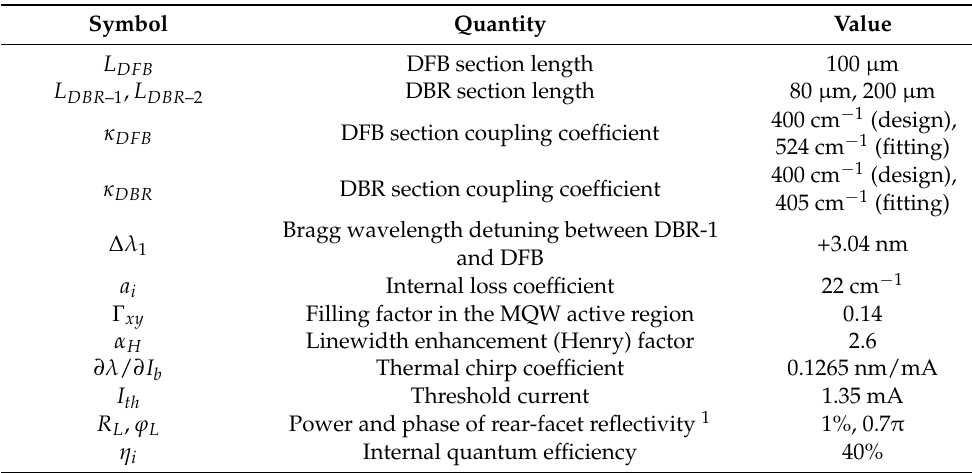
Table A1. Simulation parameters used in this work. Additional parameters related to the carrier recombination rate and gain can be found in